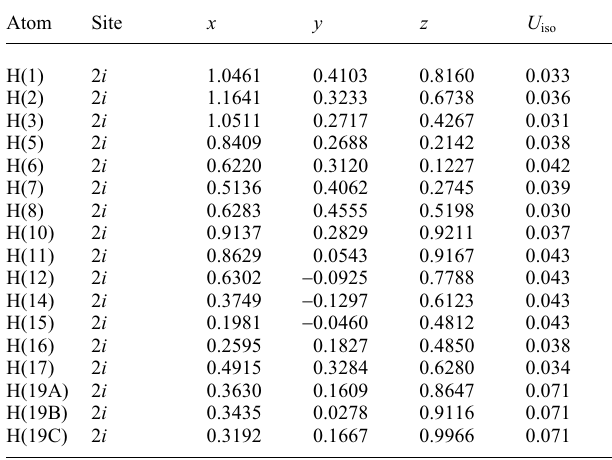
Table 2. Atomic coordinates and displacement parameters (in Å 2 )